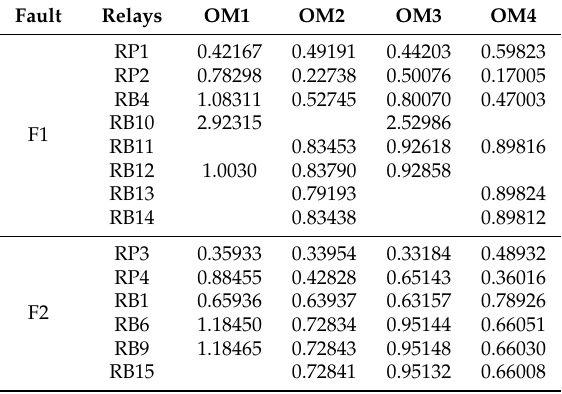
Table 15. Operation times for different OMs considering a meshed